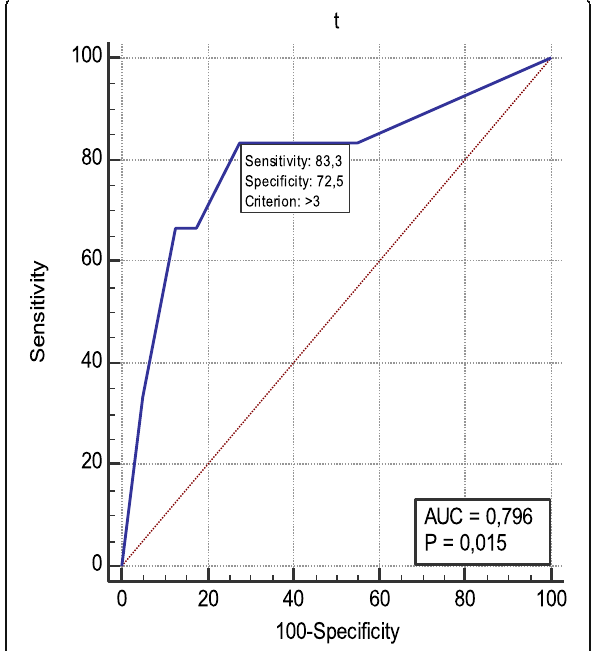
Fig. 2 Showing sensitivity and specificity of no. of leads with f-QRS to in-hospital death